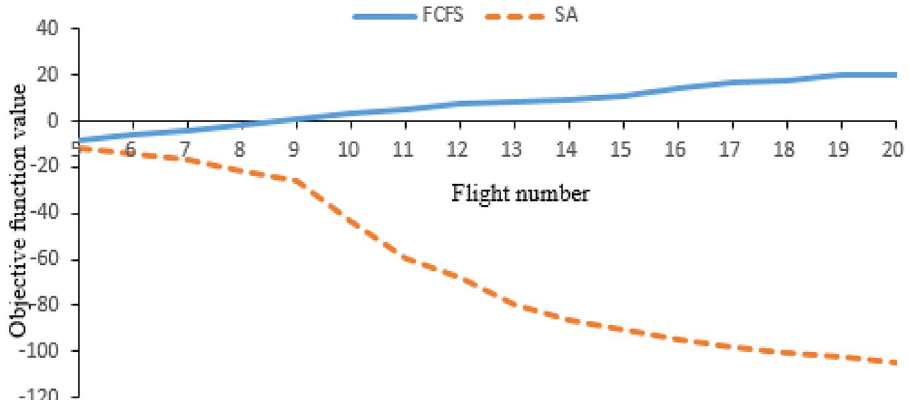
Fig. 9 The objective function value of FCFS and